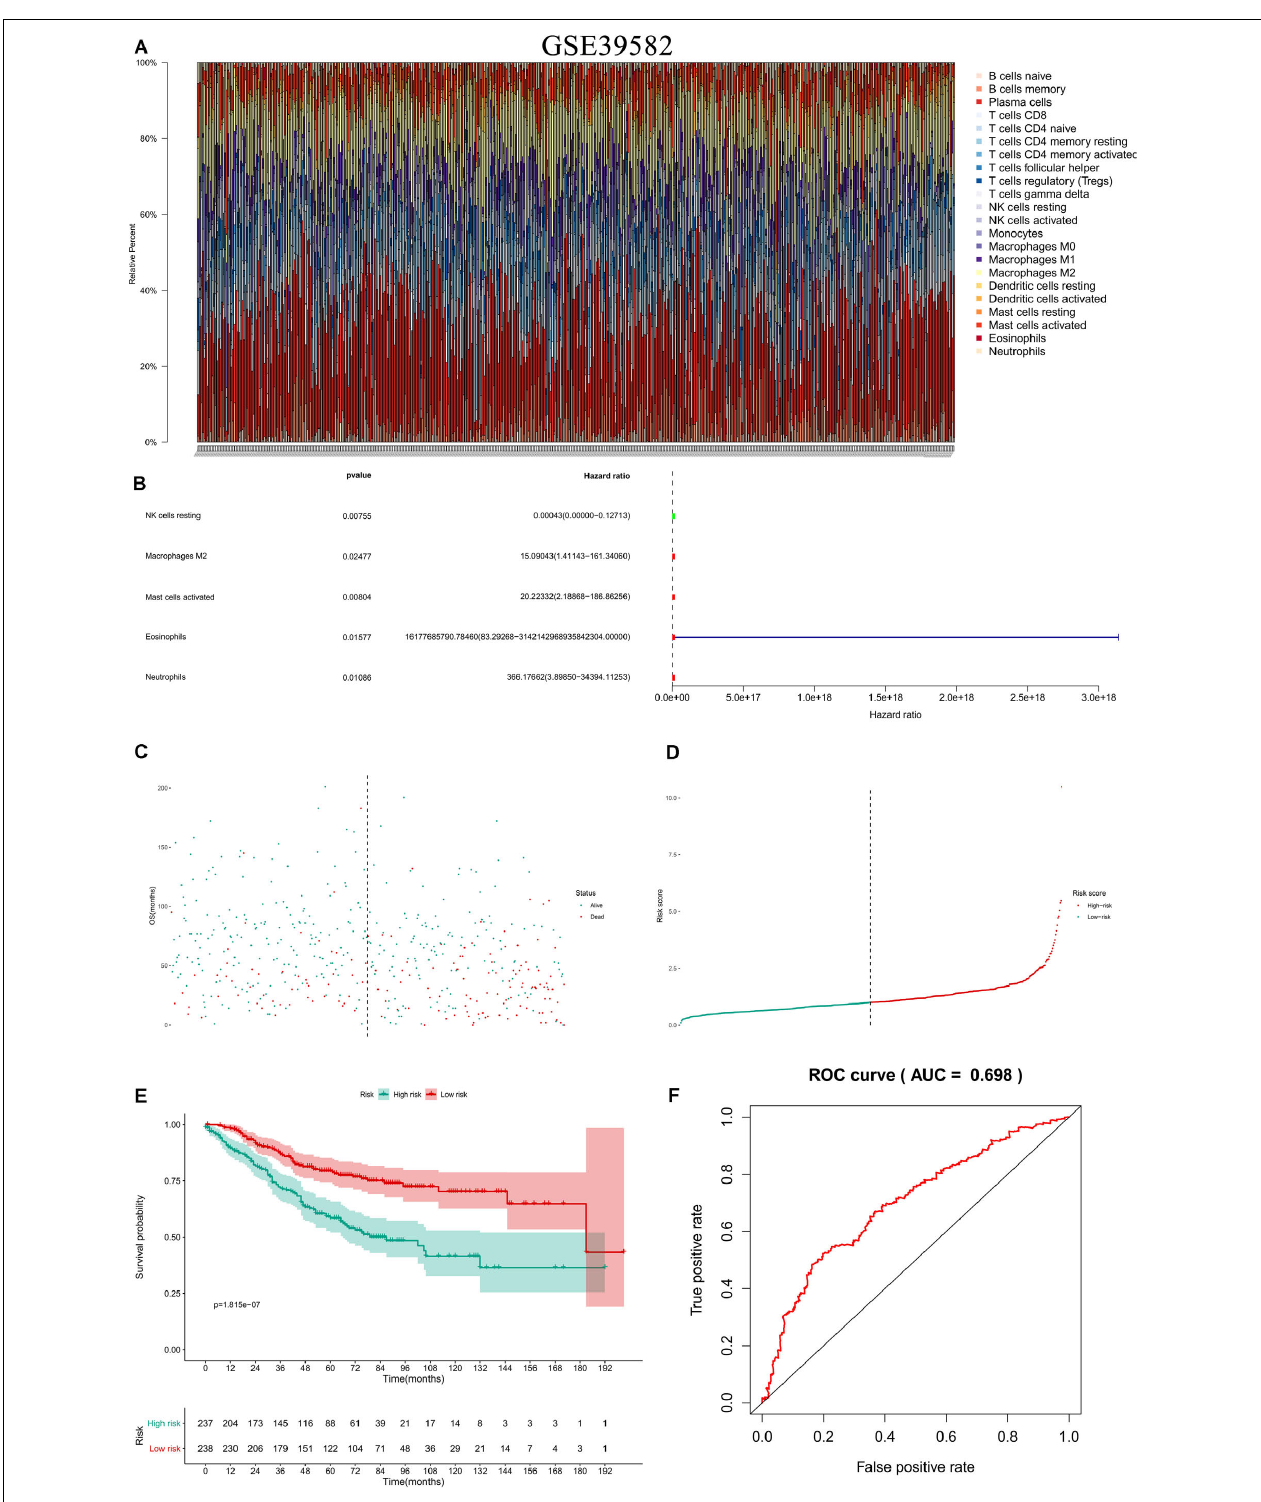
FIGURE 12 | Independent data sets validation of CIBERSORT by GSE39582. GSE39582 with 585 COAD samples was used to validation of CIBERSORT (A) . The results suggested that Macrophages M2 had significantly prognostic value for COAD (B) . Furthermore, the risk score for each COAD patient was calculated by the formula of multivariate Cox regression model. The distribution of risk score among all COAD patients were shown by the risk line and risk scatterplot (C,D) . Kaplan-Meier survival curve suggested risk score had prognostic value for COAD patients ( E , P < 0.001). And the ROC curve (AUC = 0.698) illustrated acceptable discrimination of the multivariate Cox regression model (F)